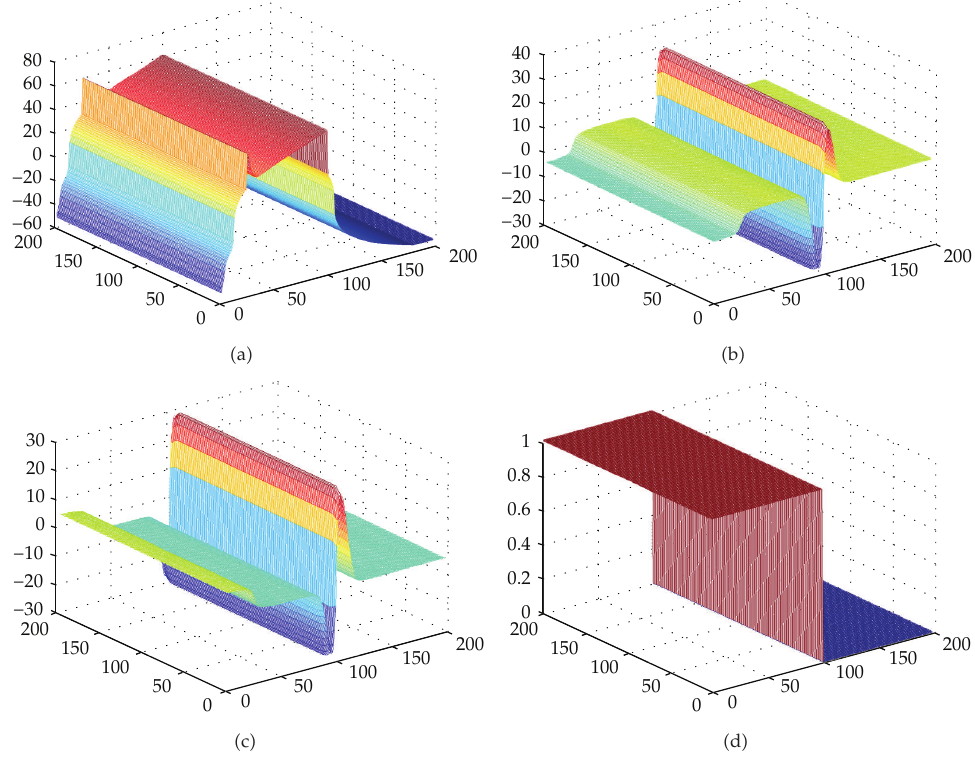
Figure 7: The mesh figures of the final level set function φ with di ff erent models for the image from Figure 6. (cid:6) a (cid:7) The final φ with the CV model. (cid:6) b (cid:7) The final φ with the LBF model. (cid:6) c (cid:7) The final φ with the LGIF model. (cid:6) d (cid:7) The final φ with the proposed